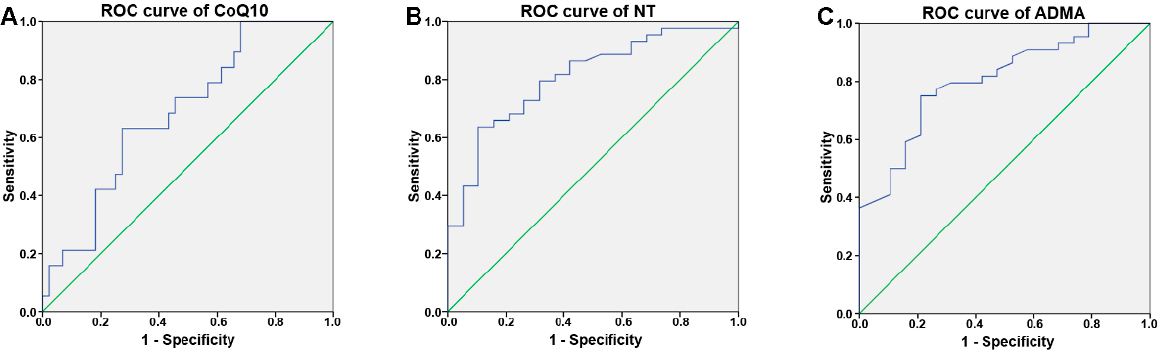
Figure 2. Receiver operating characteristic (ROC) curve for CoQ10 ( A ), NT ( B ), and ADMA ( C ) for their diagnostic performance in patients with PT and CHD ( n = 44).